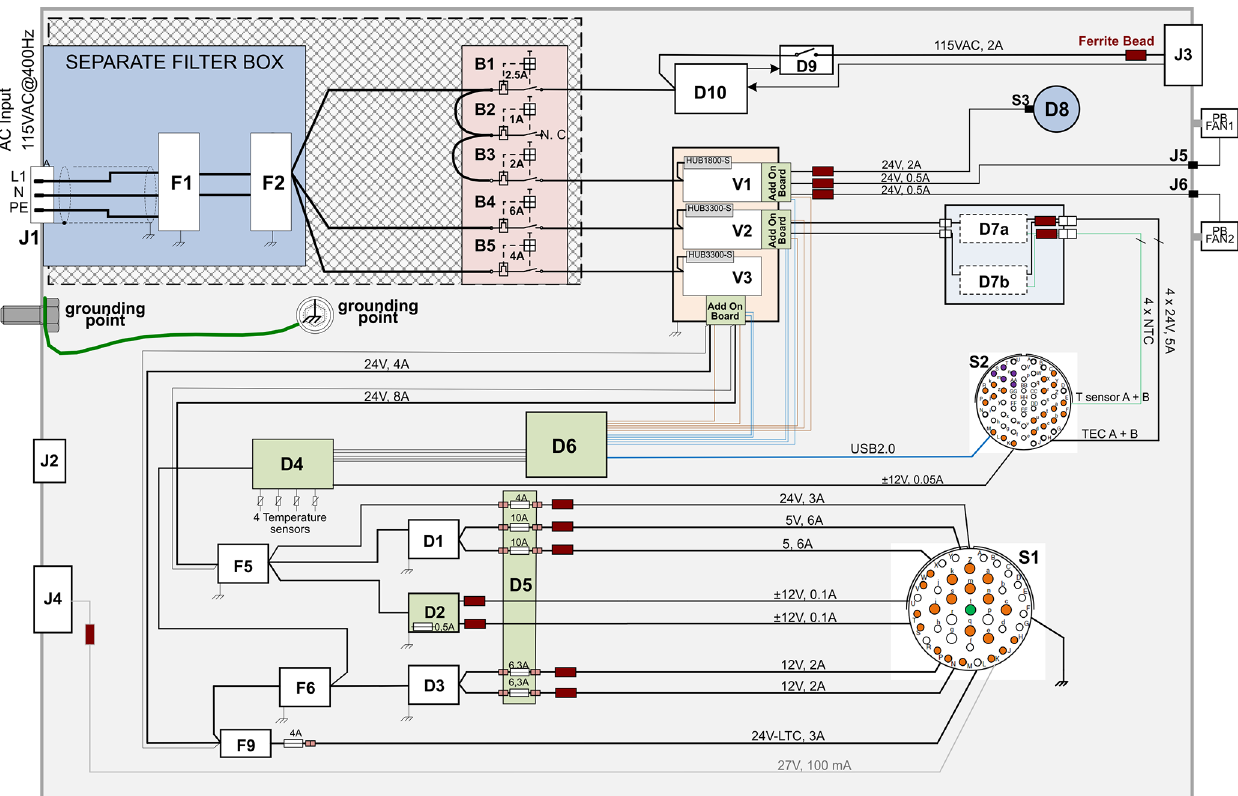
Figure 5. Simplified block diagram of the AMICA powerbox. Component and connector positions and sizes are not drawn to scale; identifiers correspond to those used in Table 2. Custom-designed boards are shown in green. Power wires are shown as thicker black lines labelled with voltage and nominal current, with dark red boxes showing the position of ferrite beads. Thinner lines mark signal connections for various